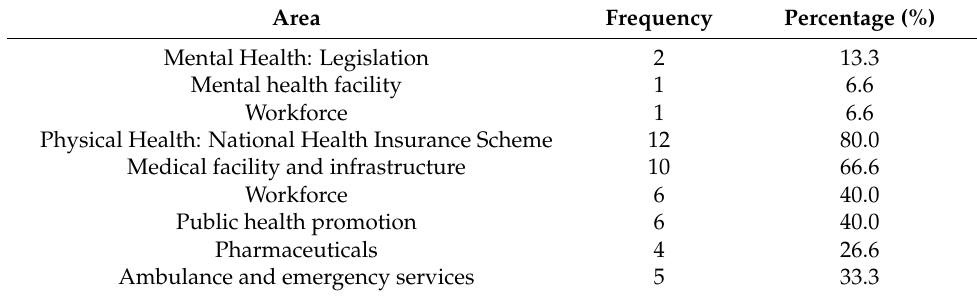
Table 2. Areas of health investment and policy direction for the ensuing